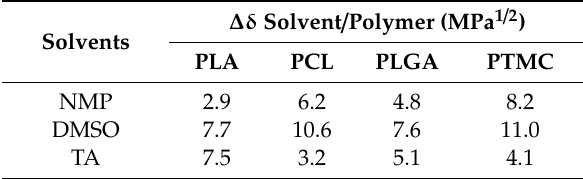
Table 2. The comparison Δδ between solvents and polymers.